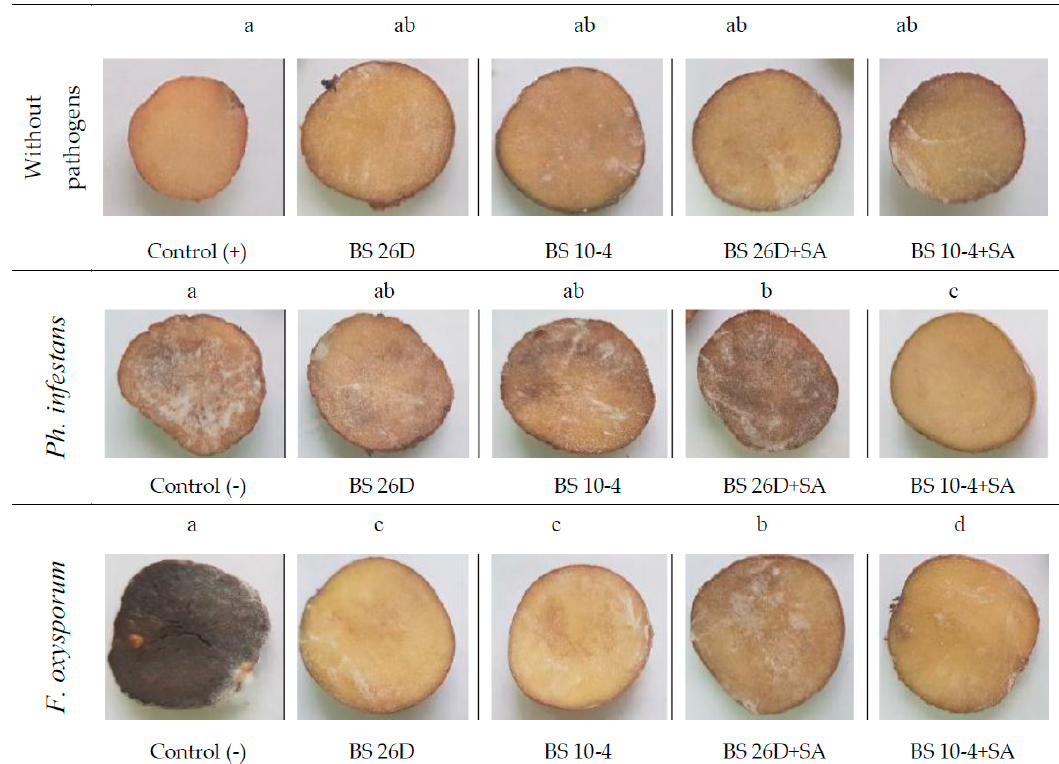
Figure 3. The effect of selected concentrations of B. subtilis 10-4 (10 8 CFU/mL) and 26D (10 8 CFU/mL), separately and compositions with SA, ( B. subtilis 10-4 (10 7 CFU/mL) + SA; B. subtilis 26D (10 6 CFU/mL) + SA) on the development of F. oxysporum and Ph. infestans in potato tubers during storage (after 5 months storage). In figure presented the pictures of medium tubers from five repetitions ± SEM. Different letters indicate a significant difference between the means at the probability level of p < 0.05.